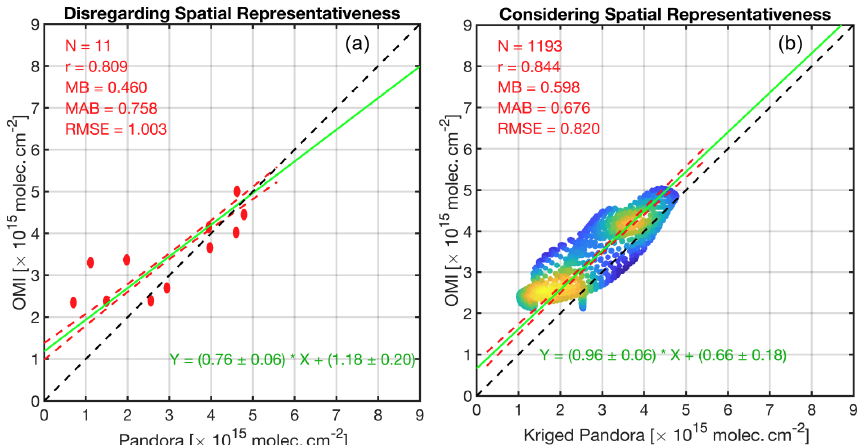
Figure 15. (a) The direct comparison of OMI tropospheric NO 2 columns with 11 pointwise Pandora measurements in September 2013 over Houston. (b) Same for the y axis, but the PSI measurements are translated to grid boxes using kriging convolved with the OMI spatial response function. PSI tropospheric NO 2 columns are estimated based on subtracting the OMI stratospheric NO 2 columns (2 . 8 ± 0 . 16 × 10 15 moleculescm − 2 ) from the total columns. We only consider kriging estimates whose errors are below 1 . 2 × 10 15 moleculescm − 2 . The kriging variance is also considered using the Monte Carlo method applied on χ 2 . The slope has improved after considering the modeled spatial representativeness. MB: mean bias (OMI vs. Pandora); MAB: mean absolute bias; RMSE: root mean square